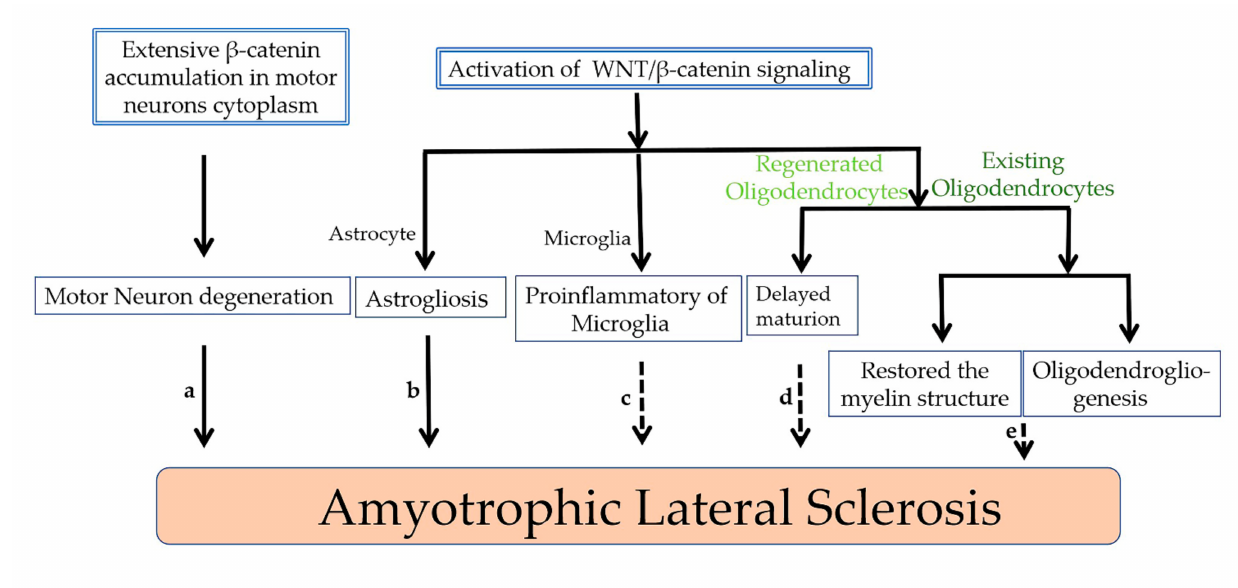
Figure 3. WNT/ β –catenin signaling and β –catenin protein contribute to the onset of ALS. a . The extensive accumulation of β -catenin in motor neurons results in the degeneration of motor neurons in ALS. b . Activation of WNT/ β –catenin signaling affects astrogliosis in ALS. c . Activation of WNT/ β –catenin signaling promotes the transformation of microglia to proin- flammatory phenotype. d . Activation of WNT/ β –catenin signaling delays the maturation of regenerated oligodendrocytes. e . For the existing oligodendrocytes, activation of WNT/ β –catenin signaling promotes the restored of degenerative myelin structure and oligodendrogliogenesis. Black arrows represent confirmed phenomena in ALS; dashed arrows illustrate hypothetical models in